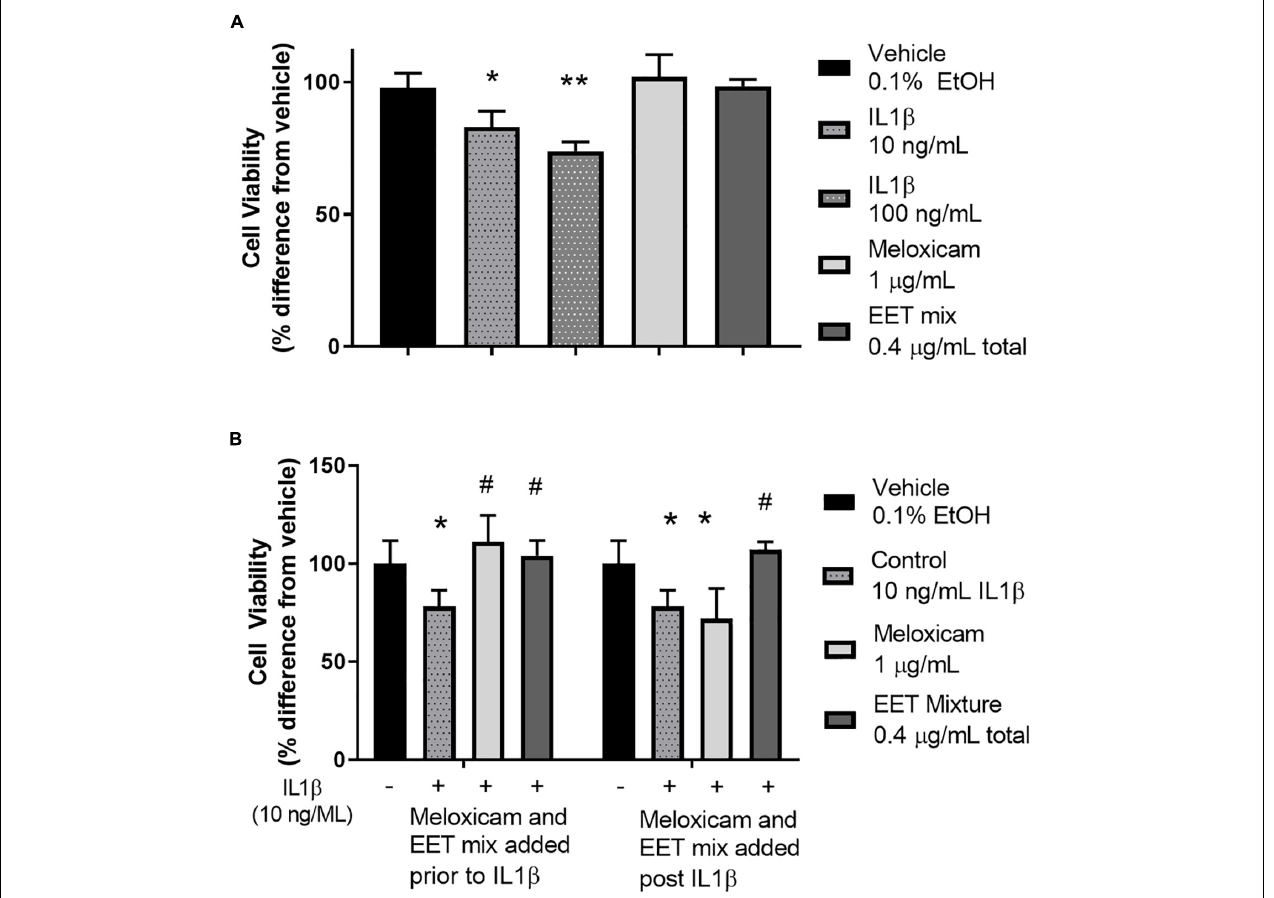
FIGURE 4 | IL1 β induced cytotoxicity was alleviated by meloxicam or EET mixture in an in vitro model of OA. (A) CnC cells treated 2 h with IL1 β showed a dose dependent increase in cytotoxicity measured by Alamar Blue. The meloxicam or EET mixture, treated for 48 h, in the absence of IL1 β , had no effect on healthy CnC cells. (B) Chondrocytes treated with IL1 β for 2 h before or after treatment with meloxicam (1 µ g/mL) or a mixture of EETs (5,6 EET, 8,9 EET, 11,12 EET, and 14,15 EET each at 0.1 µ g/mL for a total EET concentration of 0.4 µ g/mL). Meloxicam (added before the addition of 10 ng/mL of IL1 β ) or EET mixture, added either before or after a 2-h IL1 β treatment significantly reduced IL1 β induced cytotoxicity. Meloxicam added after IL1 β did not result in significant reduction in cytotoxicity. ∗ p < 0.05, ∗∗ p < 0.005 compared to vehicle not treated with IL1 β ; # p < 0.005 compared to vehicle treated with IL1 β